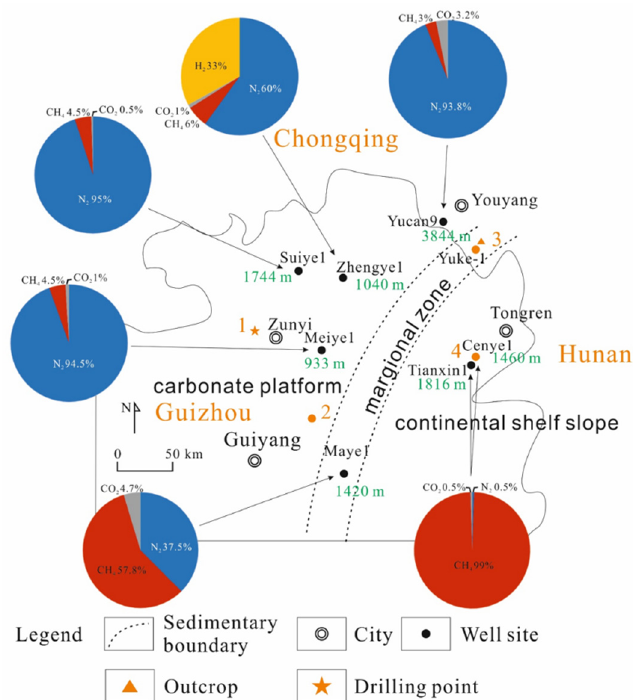
Figure 14. Exploration well distribution and shale gas composition of the Niutitang shale in the northern Guizhou area (data obtained from [9,10,13,33,53]). Sections: 1—Jindingshan; 2—Kaiyang; 3—Youyang; and 4—Cen’gong. Along the carbonate platform-to-basin transect, the permeability of floor interval decrease, and the methane content of the Niutitang shale increases gradually.